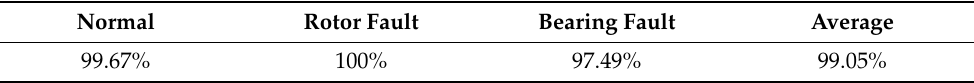
Table 5. Diagnostic accuracy of multilayer neural network through two-fold cross-validation. Normal